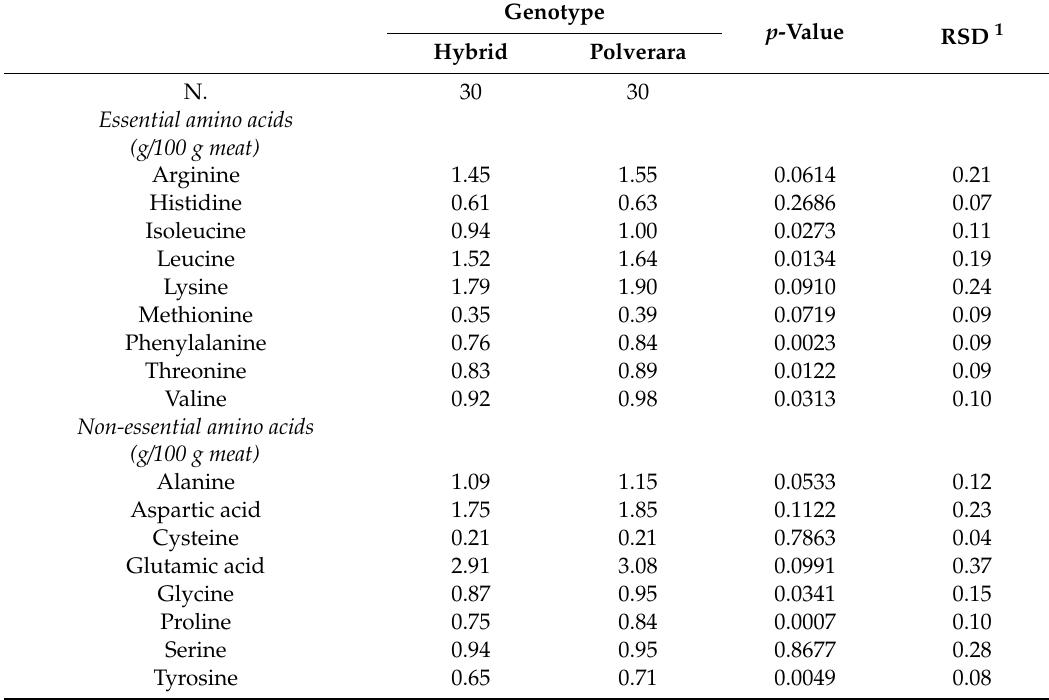
Table 3. E ff ect of chicken genotype (Hybrid vs. Polverara) on the amino acid profile of leg meat.